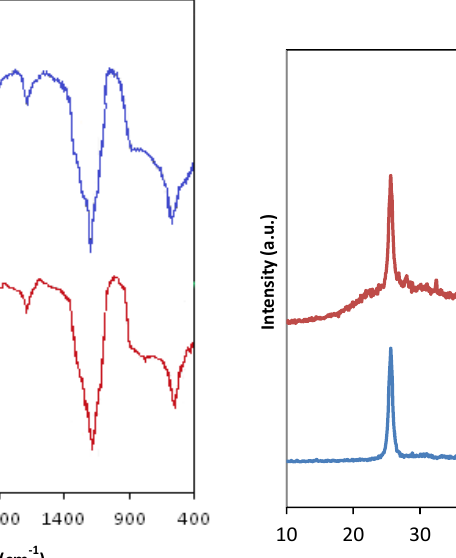
Fig. 8. FT-IR spectrum of the TiO 2 /SiO 2 and Ag NPs/TiO 2 /SiO 2 Fig. 9. XRD pattern of the TiO 2 /SiO 2 and Ag NPs/TiO 2 /SiO 2 Fig. 8 FT-IR spectrum of the TiO 2 /SiO 2 and Ag NPs/TiO 2 /SiO 2 samples samples samples Fig. 9 XRD pattern of the TiO 2 /SiO 2 and Ag NPs/TiO 2 /SiO 2 samples